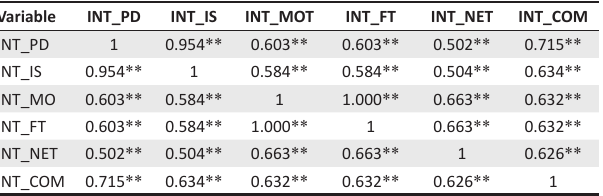
TABLE 3: Bivariate correlations of the Interaction meta-competency.